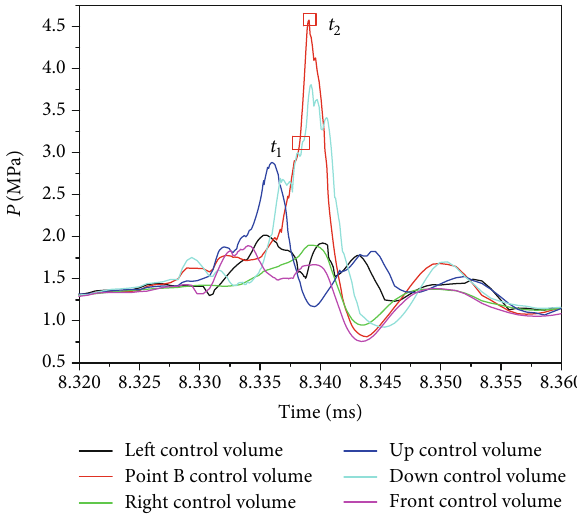
Figure 9: Pressure oscillations in the surrounding vertexes of a monitored